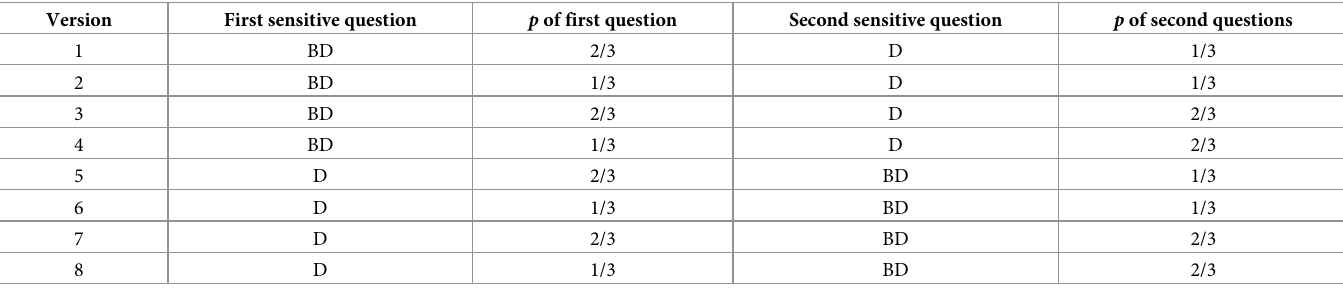
Table 1. Explanation of the different questionnaire